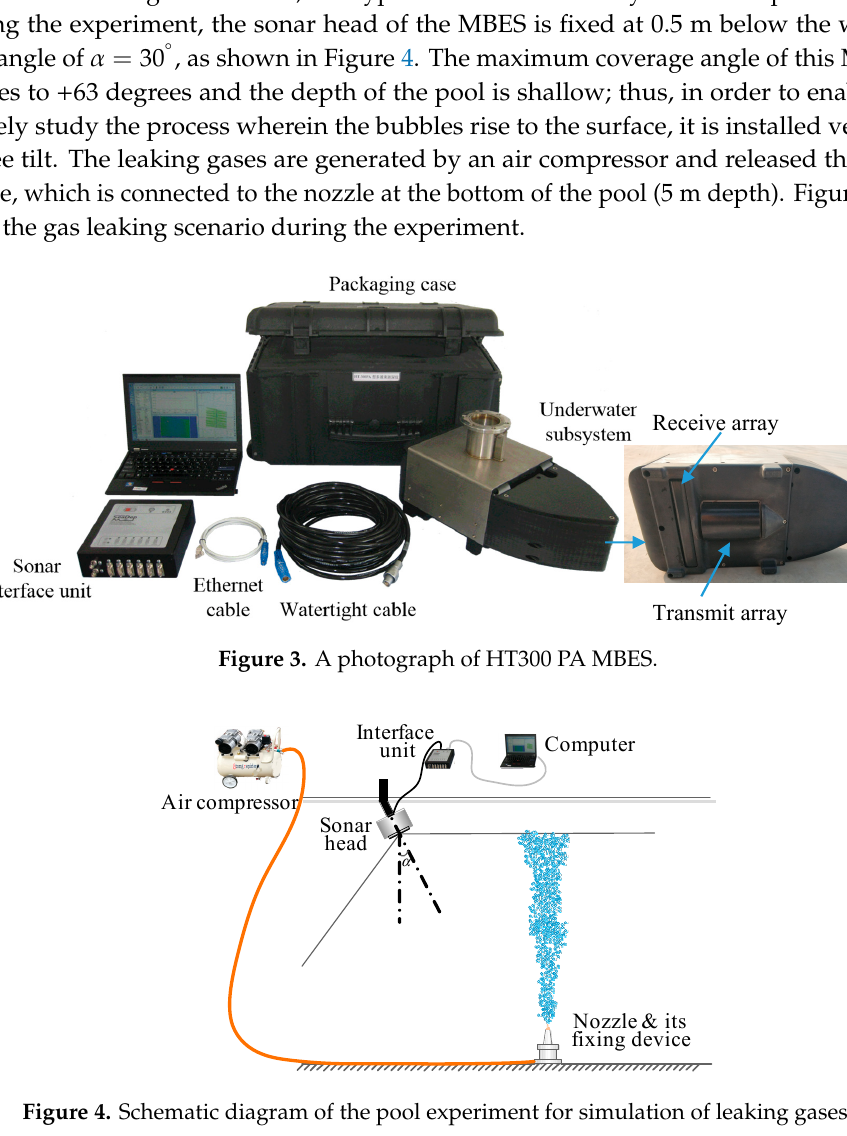
Figure 5. An underwater video screenshot of the bubbles being released. 3.1.2. Optical Flow Calculation of the Water Column Images (WCIs) Containing Leaking Gases Figure 6a,b are D-T images taken via the conventional beamformer ( CBF ) and the MVDR beamformer, respectively, and both matrix data are normalized and displayed in decibels. The fixed nozzle diameter is =0.6 mm φ ; the output intensity and the output flow rate of the air compressor are 0.1 MPa and 6.3 L/min, respectively; and the sonar head is stationary. In Figure 6a, fan-shaped bright strings are formed at the MSR, and their brightness is close to the intensity level of gas emissions. In this experiment, the gassy release area is designed outside the MSR and its purpose is to consider whether the detection of the gas emissions is still valid when they occur in an area that have significant interference from sidelobe contamination. Figure 6b shows that the image at the MSR (i.e., the region where the sidelobe effect energy is the largest) was well-suppressed. There also is sidelobe leakage outside of the MSR, but the energy level is usually lower than that of the leaking gases. Using Figure 6b and its adjacent frame images, the motion field distribution of the obtained image region is an implementation of the Farneback optical flow algorithm in MATLAB with Scheme A. In Figure 7a, the estimated velocity field is displayed in conjunction with the WCI of Figure 6b. The direction of the arrow in the figure is indicated as the direction of velocity, and the length of the arrow is the magnitude of the velocity. Since an estimated velocity value can be obtained for each pixel of the D-T image, to avoid a large number of arrows being too dense to observe, the velocity matrix here is subjected to equal interval sampling processing to display. The image of the small frame on the left side in Figure 7a is the enlarged result of the image in the red frame in the gas release